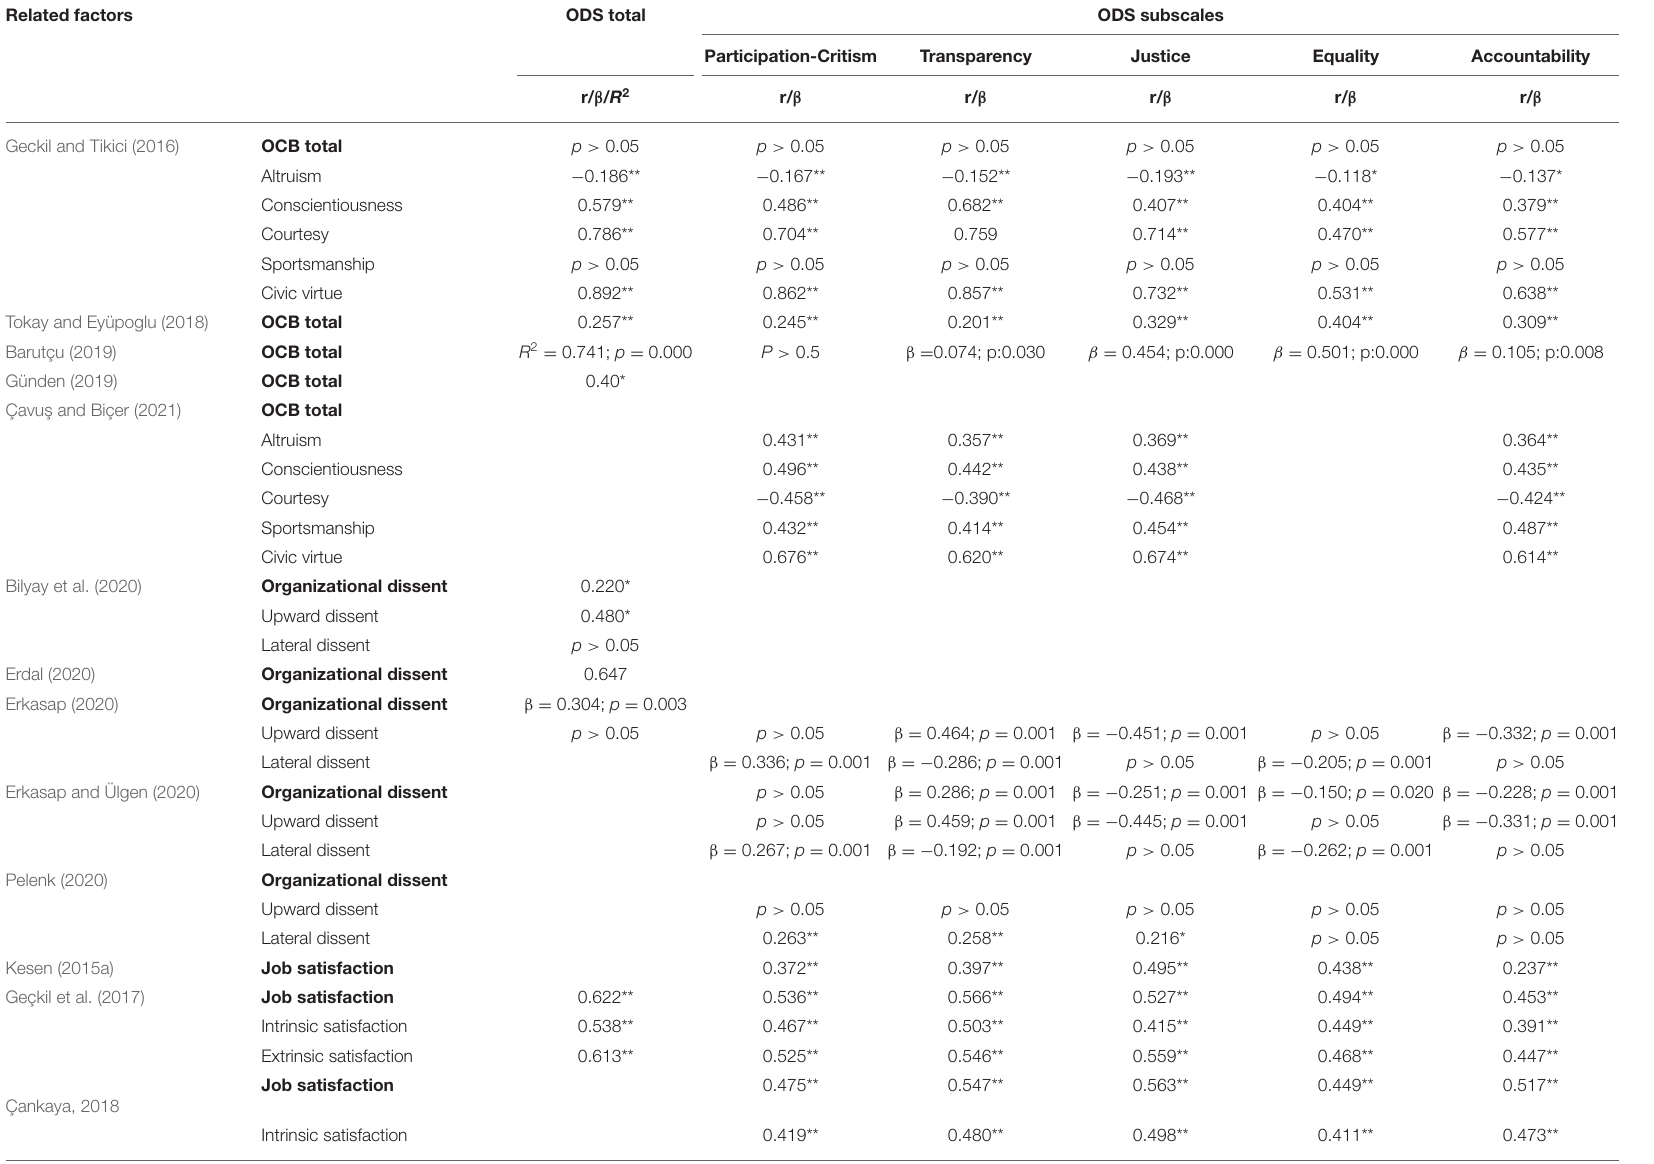
TABLE 4 | The correlations and regression of related factors with ODS total and